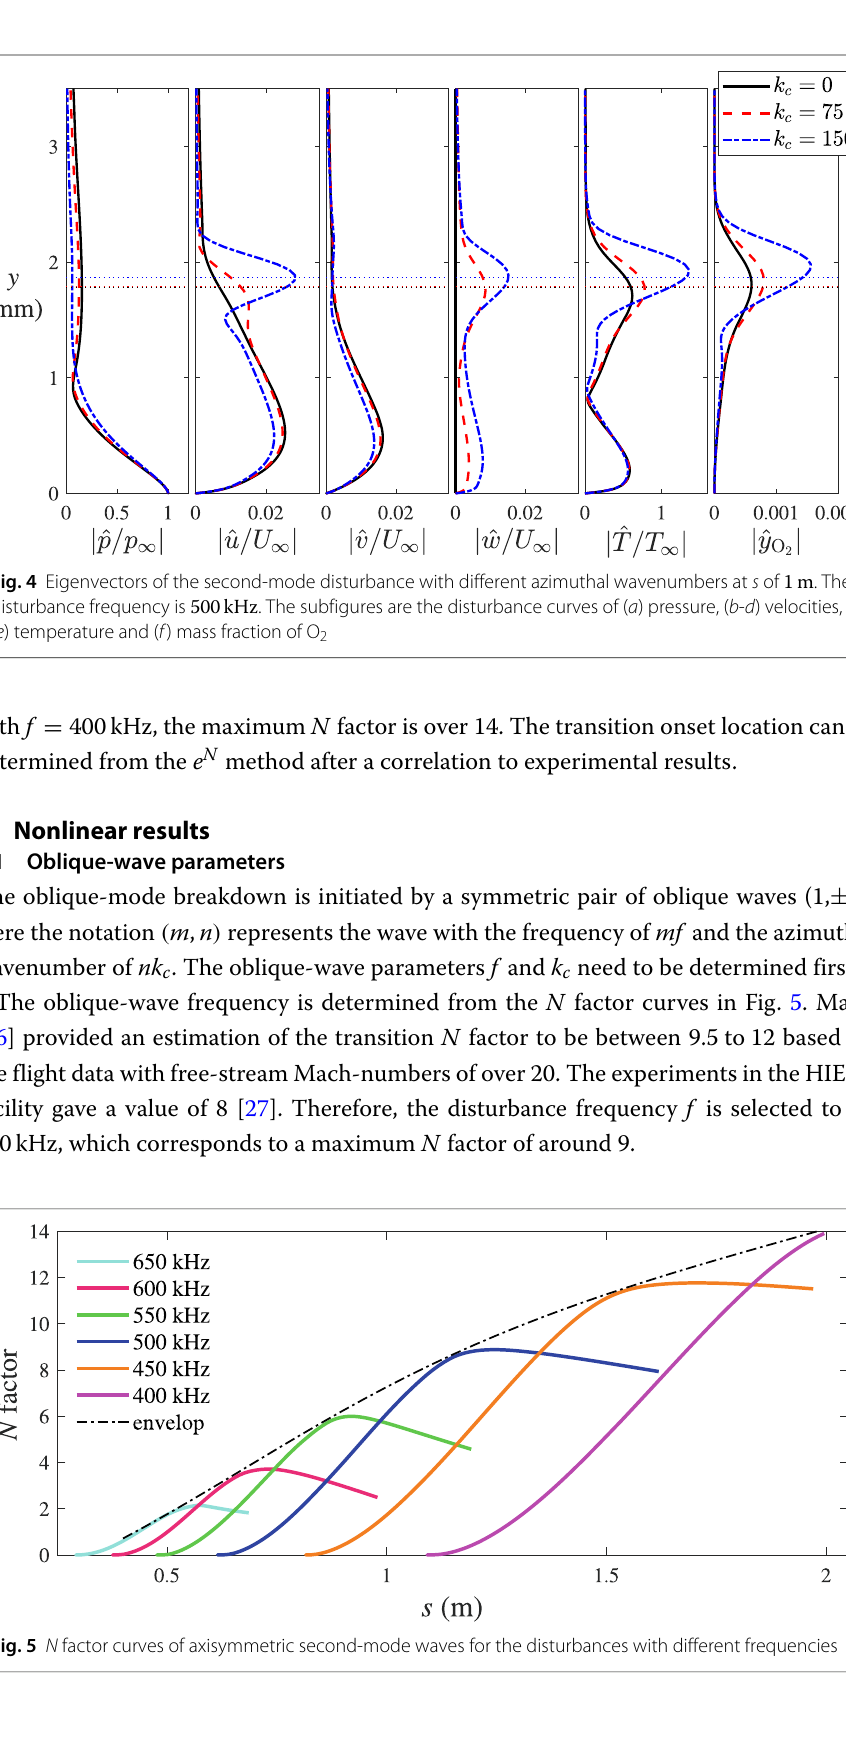
Fig. 5 N factor curves of axisymmetric second-mode waves for the disturbances with different